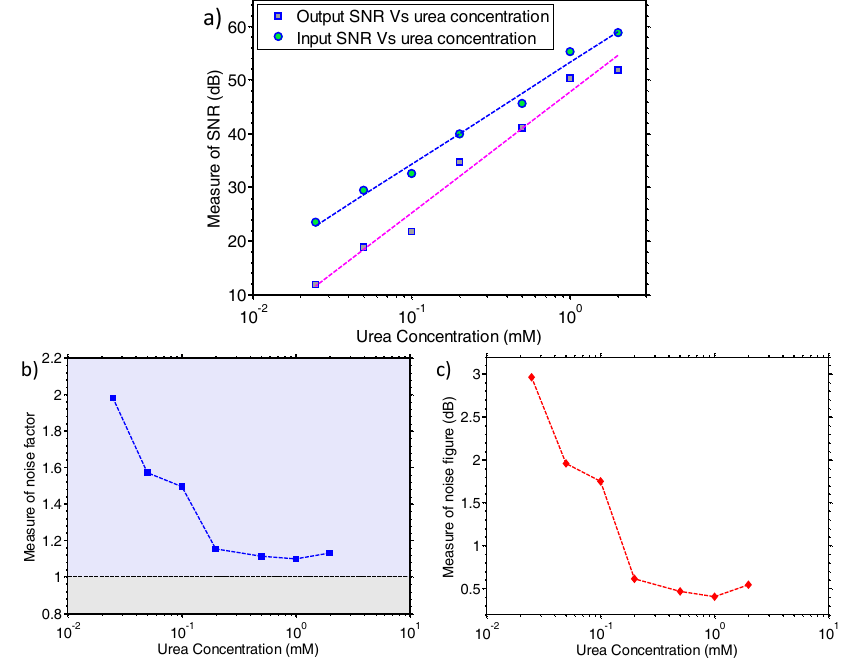
Figure 4. Noise analysis of the proposed system. ( a ) System input and output measure of SNR plotted against urea concentrations; ( b ) Measure of noise factor of the system vs urea concentrations; ( c ) Measure of noise figure of the system vs urea concentrations.